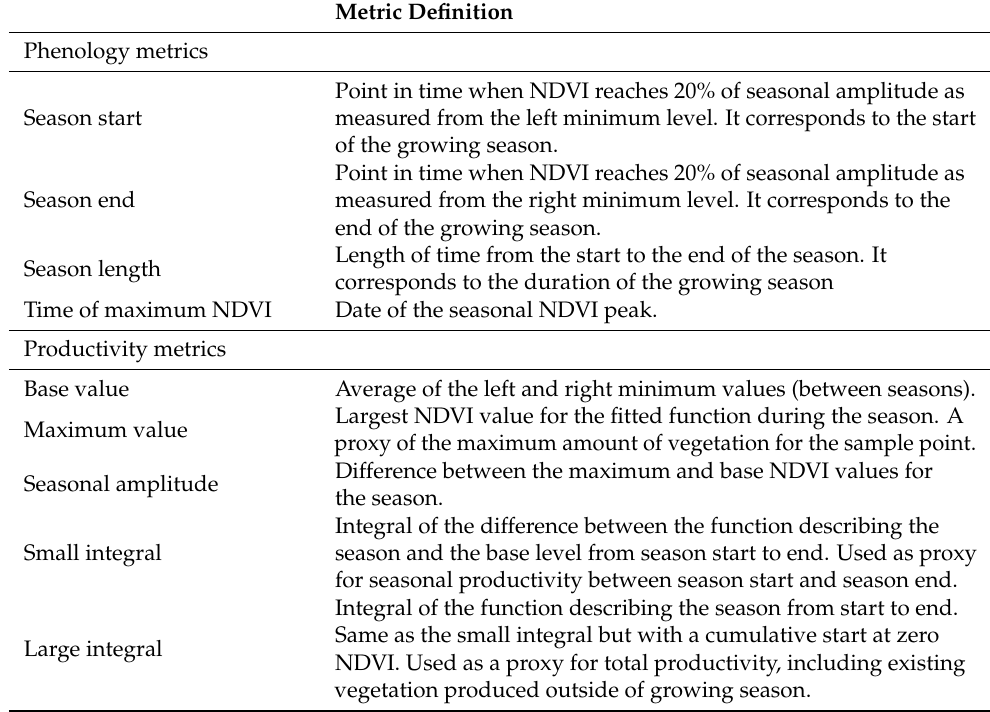
Table 1. Definition of the phenology and productivity metrics used in this study